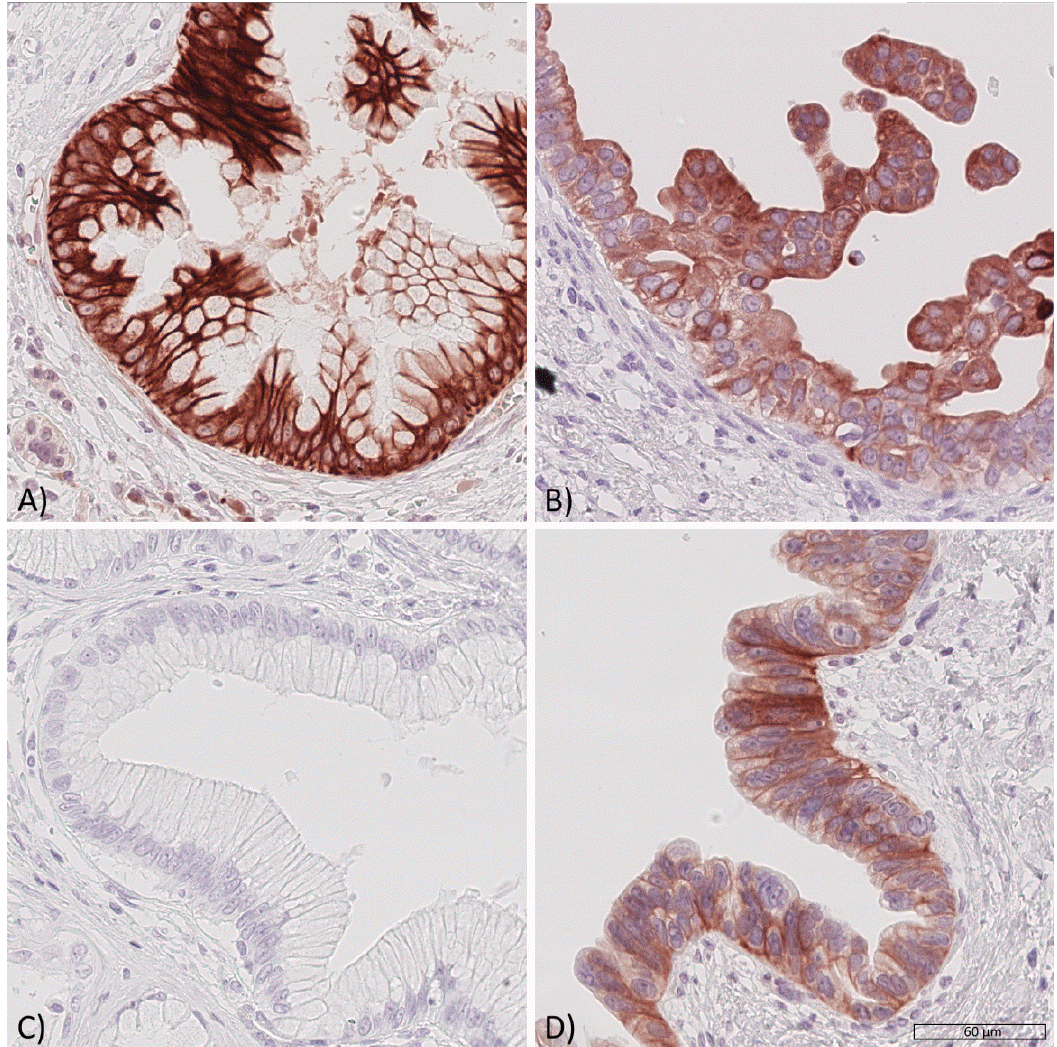
Figure 5. Expression of the insulin receptor and of the IGF1 receptor in pancreatic intraepithelial neoplasia (PanIN). Representative samples of pancreatic intraepithelial neoplasia (PanIN) showing insulin receptor and IGF1 receptor expression. A low-grade PanIN lesion with ( A ) high cytoplasmic (cCC-IR 2+) and high membranous (mCC-IR 2+) insulin receptor expression, a high-grade PanIN lesion ( B ) with low (cCC-IR 1+) as well as partially high cytoplasmic (cCC-IR 2+) insulin receptor expression and focally high membranous (mCC-IR 2+) insulin receptor expression, a low-grade PanIN lesion ( C ) lacking IGF1 receptor expression and a high-grade PanIN lesion ( D ) showing low cytoplasmic (c-IGF1R 1+) and high membranous (m-IGF1R 2+) IGF1 receptor expression. Original magnification A-D: 400×. Table 4. Comparison of insulin receptor (IR) and IGF1 receptor expression between pancreatic cancer samples and corre- sponding intratumoral PanIN lesions.